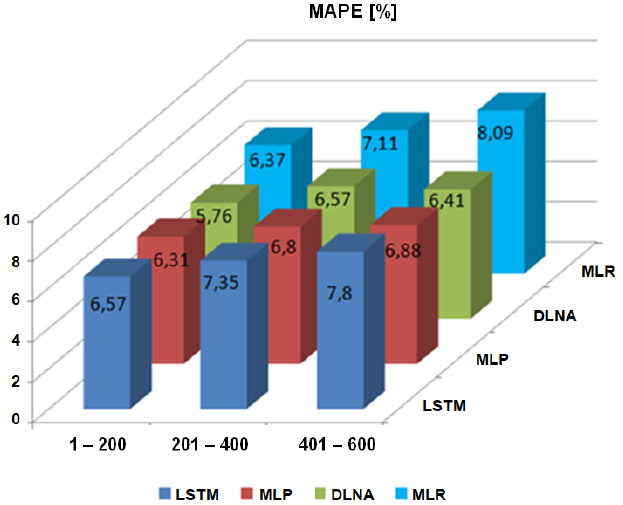
Figure 15. MAPE energy estimation error for four methods for a test set divided into three parts.